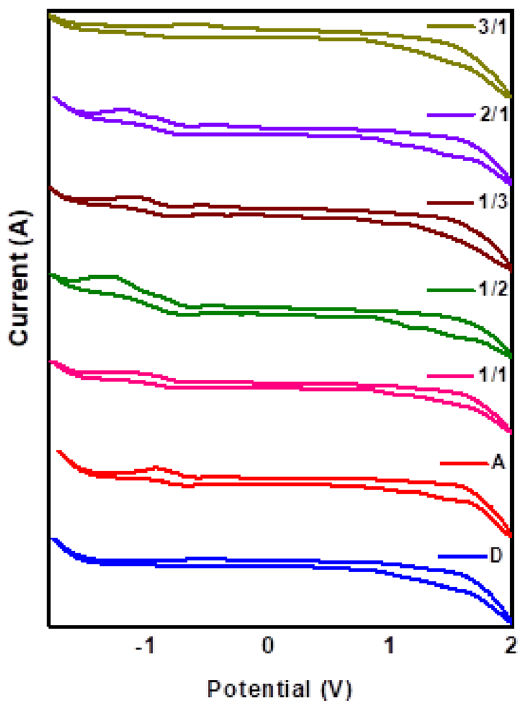
Figure 3. Cyclic voltammograms of pristine D , A and D/A blends Graph was plotted using Origin software (https ://www.origi nlab.com/, version: 8.5).